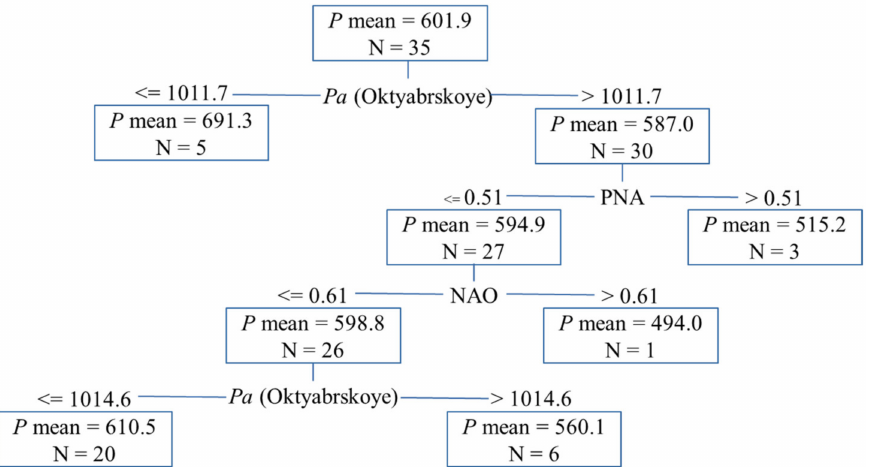
Figure 5. Decision tree for annual values of precipitation (mm/year) of the Ob’s basin, consisting of 4 branches for